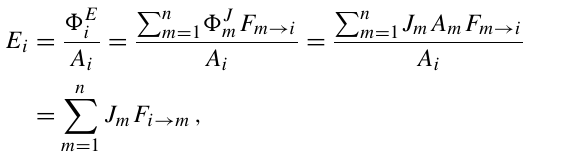
Figure 2. Calculation of the view factor between surface A i and A j by integrating over A i and A j . n ˆ vectors of the surface elements d A ˆ leads to the reciprocity property F i → j A i = F j → i A j .